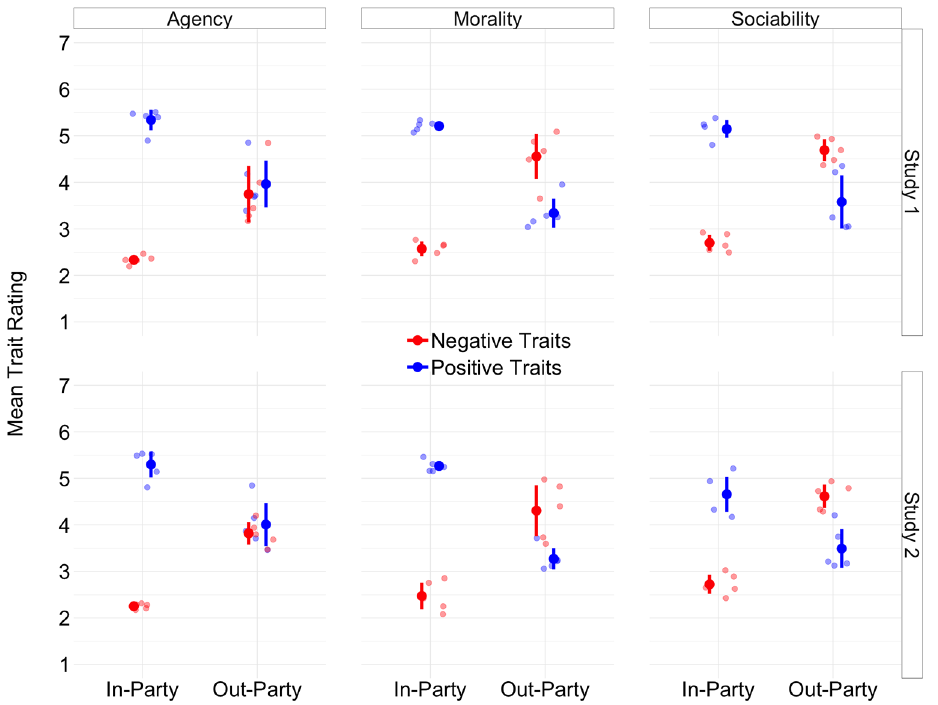
Figure 4. Mean trait ratings as a function of party target (in-party, out-party), trait valence (negative, positive) and trait domain (agency, morality, sociability) in Studies 1 and